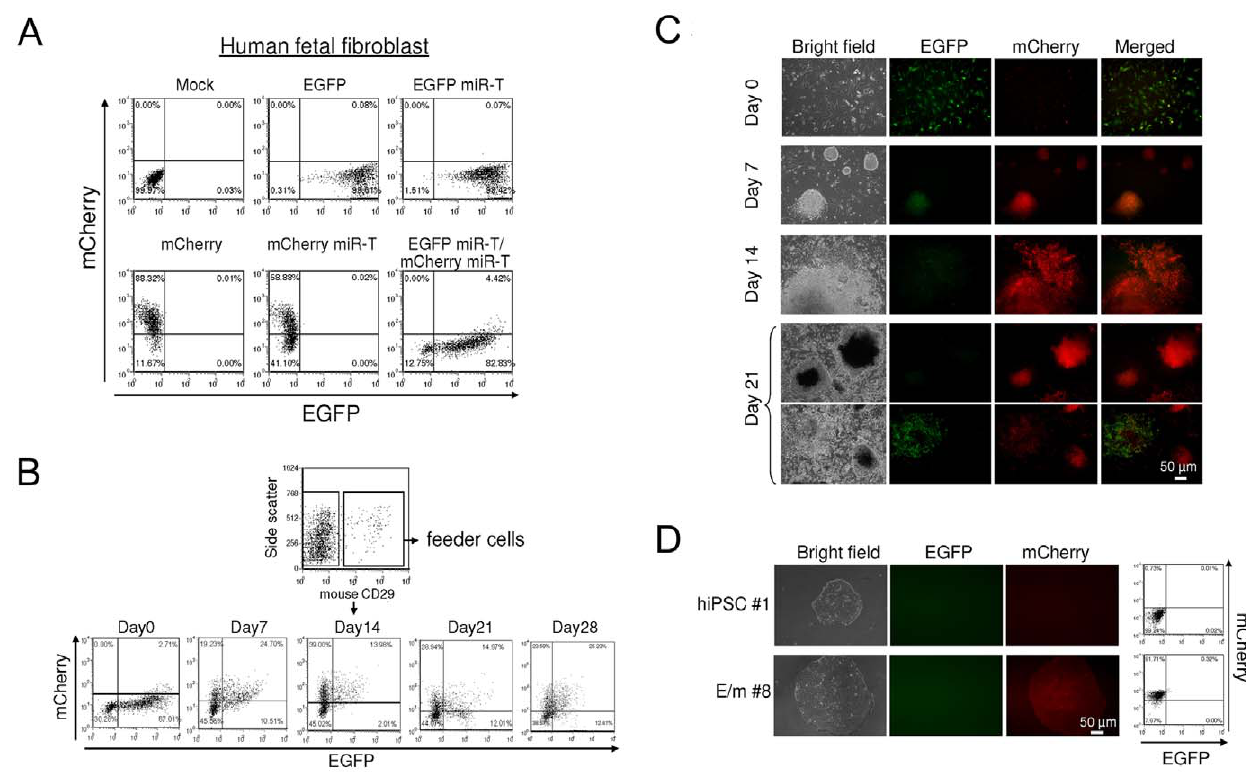
Figure 3. Reprogramming state specific expression of the reporter vector containing miRNA targets during hiPSC formation from human fetal fibroblasts (HFFs). (A) HFFs were infected with lentiviral vectors encoding various reporters shown in Fig. 1A. Expression levels of EGFP and mCherry were analyzed by flow cytometry 2 days post-infection. (B and C) HFFs were infected with lentiviral vectors encoding 4 different hiPSC factors ( OCT4, SOX2, KLF4, and cMYC ) and with or without a lentiviral vector encoding EGFP miR-T/mCherry miR-T. Cells were then cultured for 3 days and replated on irradiated mouse embryonic fibroblast (iMEF) feeder cells at 5 6 10 4 cells/60 mm plate. Expression levels of EGFP and mCherry were analyzed by flow cytometry on days 0, 7, 14, 21, and 28 (B), and by fluorescence microscopy on days 0, 7, 14, and 21 (C). iMEF feeder cells were labeled with PE-Cy7 conjugated mouse CD29 antibody and excluded from the flow cytometry analysis in (B). (D) hiPSC colonies expressing mCherry were picked on Matrigel coated plate on days 21–25 and propagated in mTeSR medium. Expression levels of EGFP and mCherry were analyzed by fluorescence microscopy and by flow cytometry. The number (%) in each quadrant is listed on each plot. hiPSC # 1: hiPSC clone without transduction of EGFP miR-T/mCherry miR-T reporter vector. E/m # 8: hiPSC clone with transduction of EGFP miR-T/mCherry miR-T reporter vector.